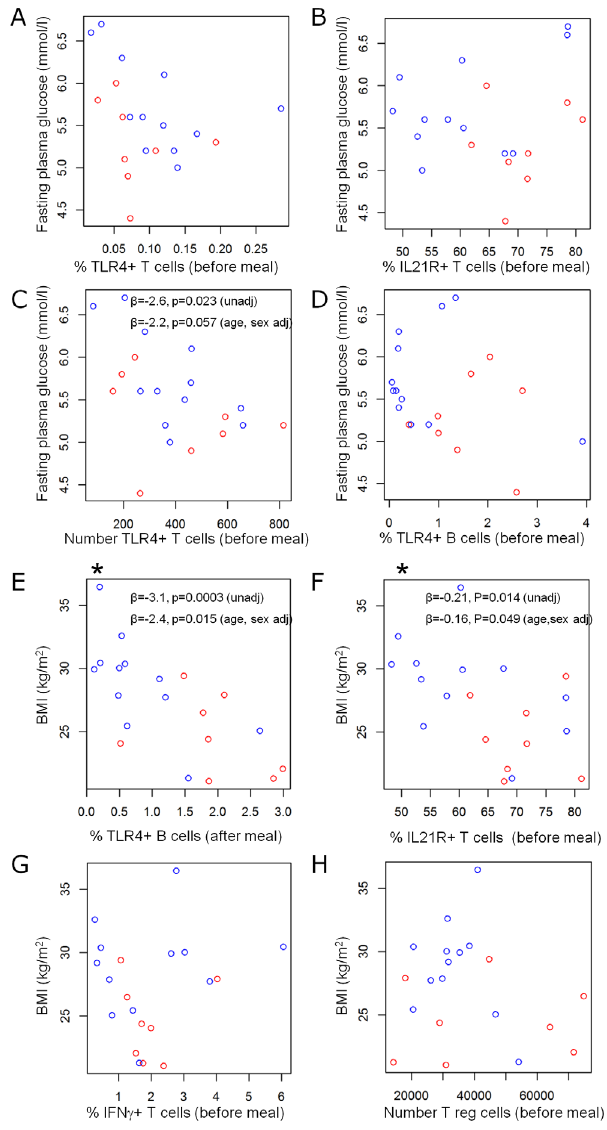
Figure 6. FPG (mmol/l) vs before meal frequency of CD3 + CD4 + IL21R 2 TLR4 + T cells (A), before meal frequency of CD3 + CD4 + IL21R + TLR4 2 T cells (B), before meal number of CD3 + CD4 + IL21R 2 TLR4 + T cells (C) and before meal frequency of CD19 + IL21R 2 TLR4 + B cells (D). BMI vs after meal frequency of CD19 + IL21R 2 TLR4 + B cells (*=significant after adjustment for multiple testing) (E), before meal frequency of CD3 + CD4 + IL21R + TLR4 2 T cells (F), before meal frequency of activated IFN- c + T cells (G) and before meal number of CD3 + CD4 + CD25 + CD127 2 T cells (H). Red dots represent women and blue dots represent men.